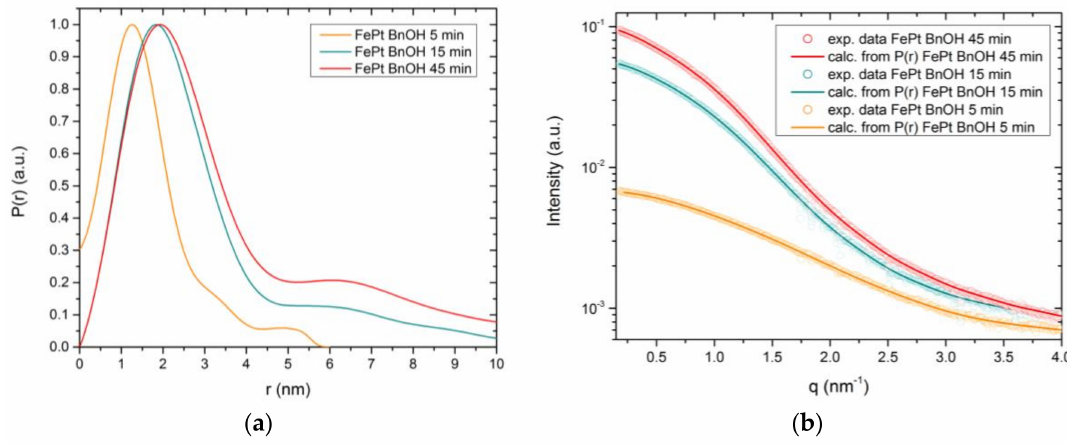
Figure A2. Pair-distance distribution functions ( a ) as well as scattering curves of the experimental data and calculations from P(r) ( b ) of the 5, 15, and 45 min samples of FePt-BnOH determined by small-angle X-ray scattering (SAXS). The scattering intensity is described as a function of the scattering vector q, with q = 4 π sin( θ )/ λ , λ as the corresponding wavelength of the X-ray source and scattering of the sample at an angle of 2 θ . The P(r) function describes the relative frequency of all paired sets of interatomic distances within the system of length r and is used to gather dimensional and morphological